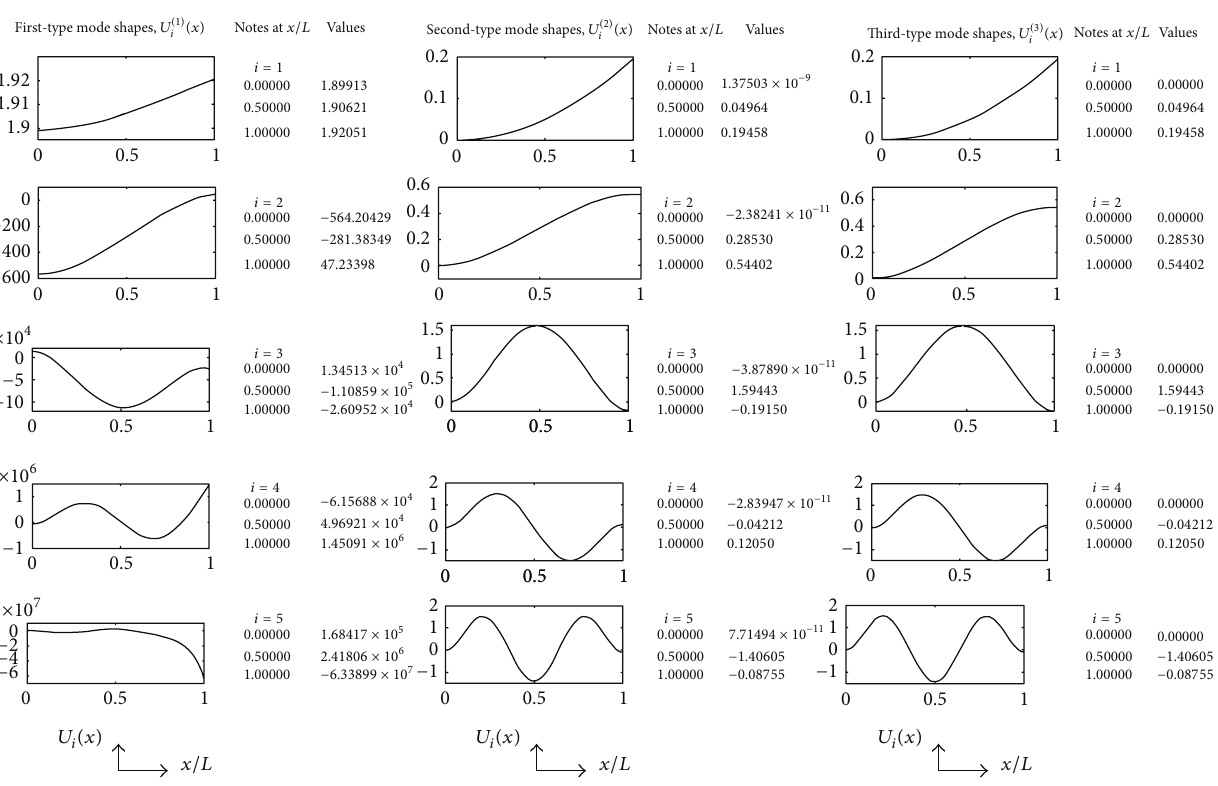
Figure 8: Three types of the first five mode shapes with the combinations of 𝜙 = 4 , 𝑘/𝐿 = 4 , and 𝑑/𝐿 = 4